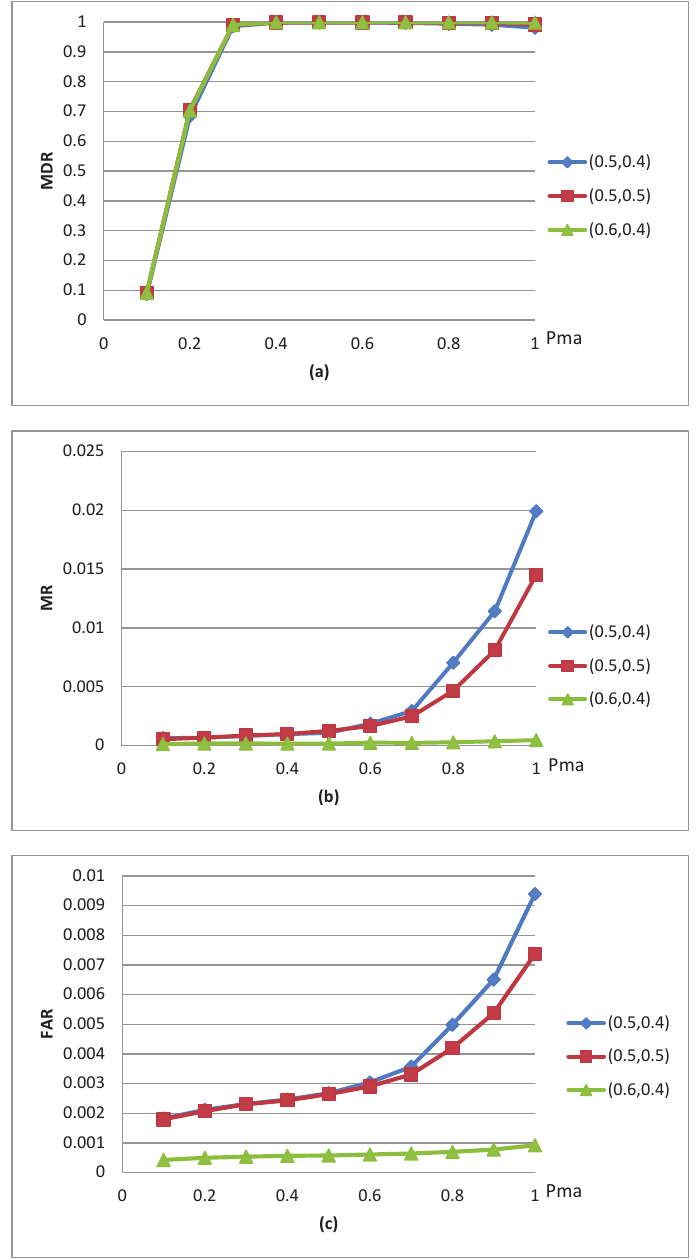
Figure 4. Malicious node detection rate (MDR), misdetection rate (MR) and false alarm rate (FAR) for various values of p when α = 0.1 and β = ma